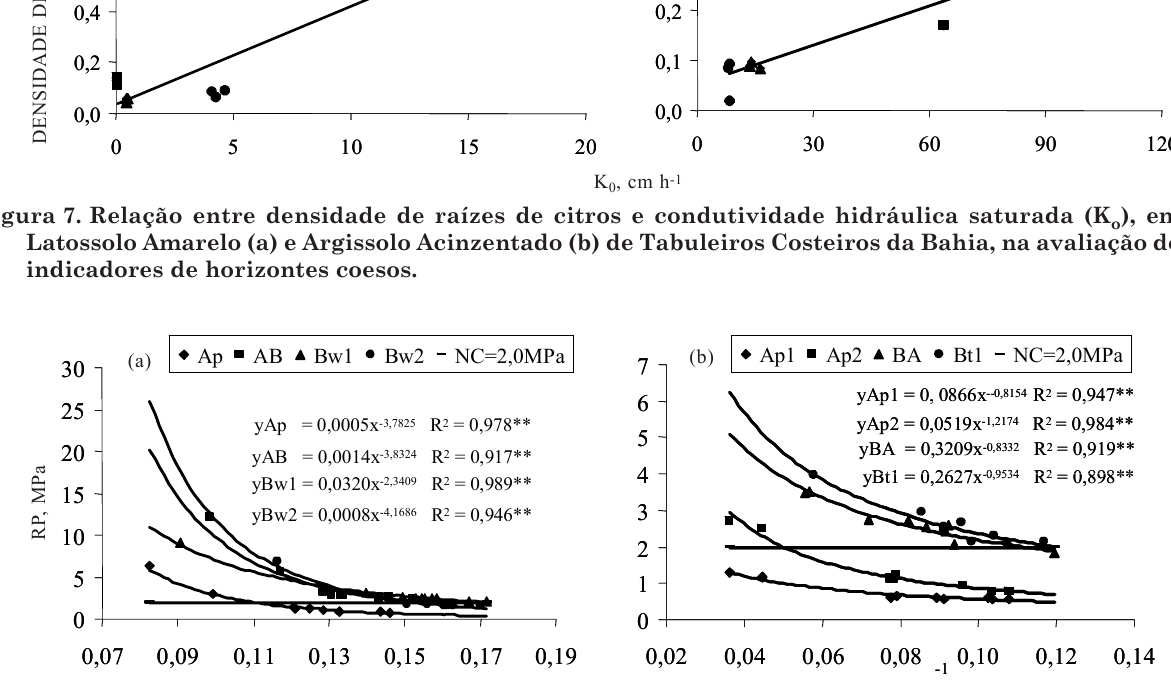
Figura 8. Curvas de resistência à penetração (RP) em relação à umidade do solo (Ug), em Latossolo Amarelo (a) e Argissolo Acinzentado (b) de Tabuleiros Costeiros da Bahia.